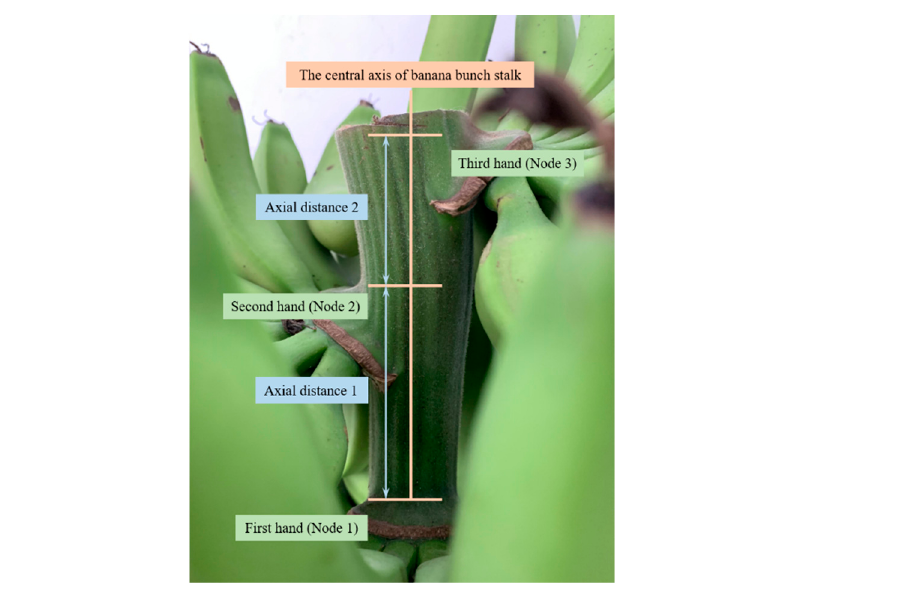
Figure 4. Schematic diagram of measuring the axial distance of banana hands.